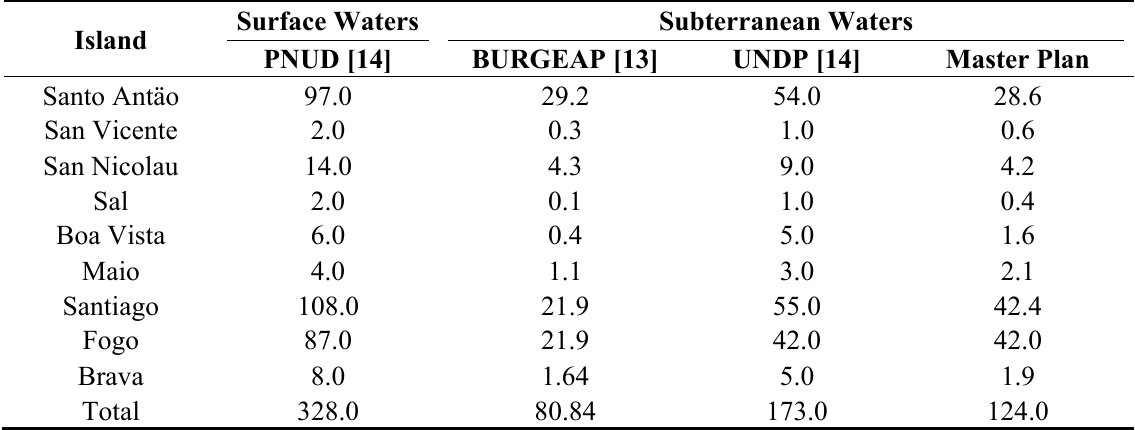
Table 2. Estimated Surface and subterranean waters (in millions of m 3 /year).